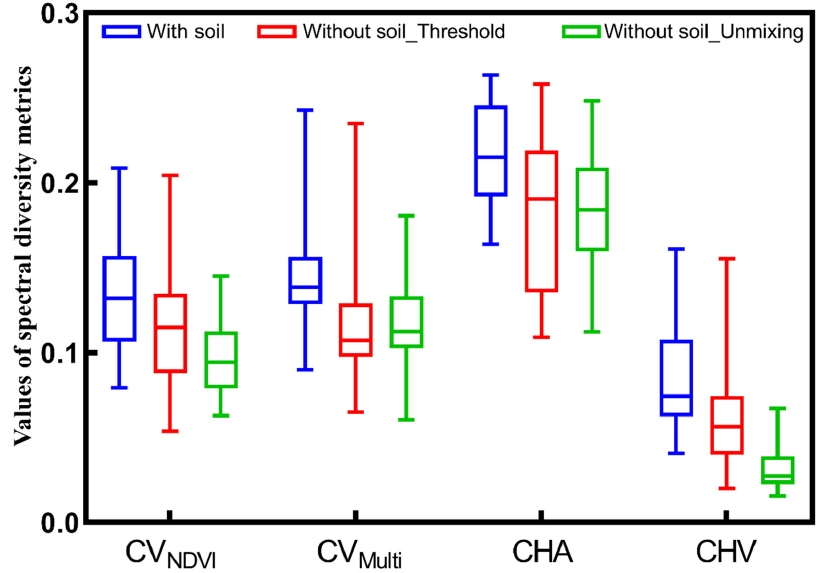
Figure 4. The variation of four spectral diversity metrics between 18 sample plots before and after soil information removal. Each box shows the maximum, the upper quartile, the mean, the lower quartile and the minimum. Each spectral diversity metric includes three conditions: with soil information (blue), without soil information, removed by setting NDVI threshold (red) and without soil information, removed by linear spectral unmixing model (green).